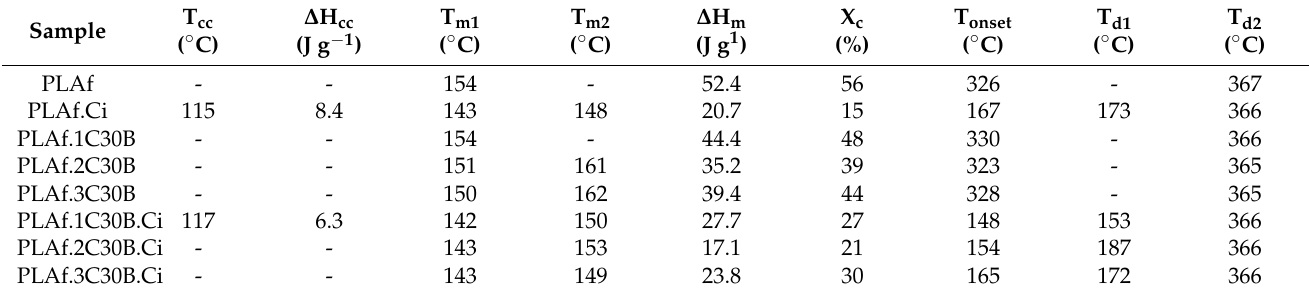
Table 2. DSC and TGA parameters of PLA nanocomposite foams impregnated with